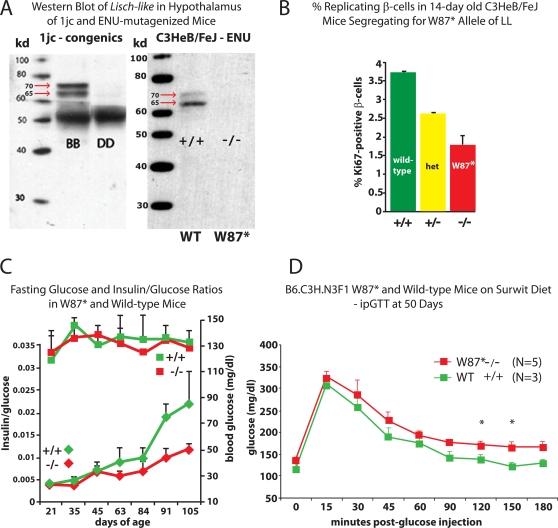
Phenotypes of Mice Segregating for the W87* Allele of Lisch-like.A) Western analysis of Lisch-like in hypothalamus of 1jc and homozygous W87* mice. The Western immunoblot shows differences in Ll expression in hypothalami of 1jc Lepob/ob B/B vs. D/D congenic males (left panel), and between wild-type C3HeB/FeJ and W87* C3HeB/FeJ males (right panel). The right panel immunoblot was incubated with rabbit anti-LL antiserum, prepared against a polypeptide corresponding to exons 7 and 8 of the ICD. The antiserum had been absorbed to fixed liver extracts from knock-out mice in order to block non-specific proteins from interacting with the antibody. The LL transcript isomers are visible as a 65 and 70 kD doublet in the B/B and C3HeB/FeJ wild-type lanes, but absent in the lanes of the 1jc-D/D congenic and C3HeB/FeJ W87* homozygous ENU mutants. B) Percent Replicating β-cells in 14-day old ENU-mutagenized mice. The percentage of Ki67-positive β-cells was estimated in 14-day old C3HeB/FeJ ENU-mutagenized mice, who were either homozygous wild-type (+/+), heterozygous (+/−), or homozygous for the W87* LL amber mutation (−/−). At 14 days there was a 2-fold difference in the % of Ki67+ β-cells in +/+ (3.75%) vs. −/− (1.75%) ENU W87* mice; +/− were intermediate (2.5%). Non-overlapping images of longitudinal pancreatic sections (200 µm apart) were acquired and analyzed using ImageJ software version 1.37 (NIH) to count insulin-positive and Ki67+ cells. Pancreatic weights of +/+ and −/− were not different. C) Fasting blood glucose (squares) and insulin/glucose ratios (diamonds) in W87* (−/−) and wild-type (+/+) littermates. P-value <0.05 for 2-tailed t-test at 63 days of age. Data points at other ages show trends. D) ipGTT on 50-day old Surwit-fed B6.CH3. N3F1 W87* males. Glucose intolerance is seen in W87* mice. Mice were fasted overnight prior to dextrose injection (50% dextrose solution, 0.5 g/kg, ip). Capillary tail bleeds were performed at the specified time points to determine circulating glucose levels by glucometer (FreeStyle Flash, Abbott). Blood glucose concentrations that are marked with an asterisk are significantly different (t-test; p<0.05; mean±SEM). Area under curve +/+ vs. −/− (p = 0.02).